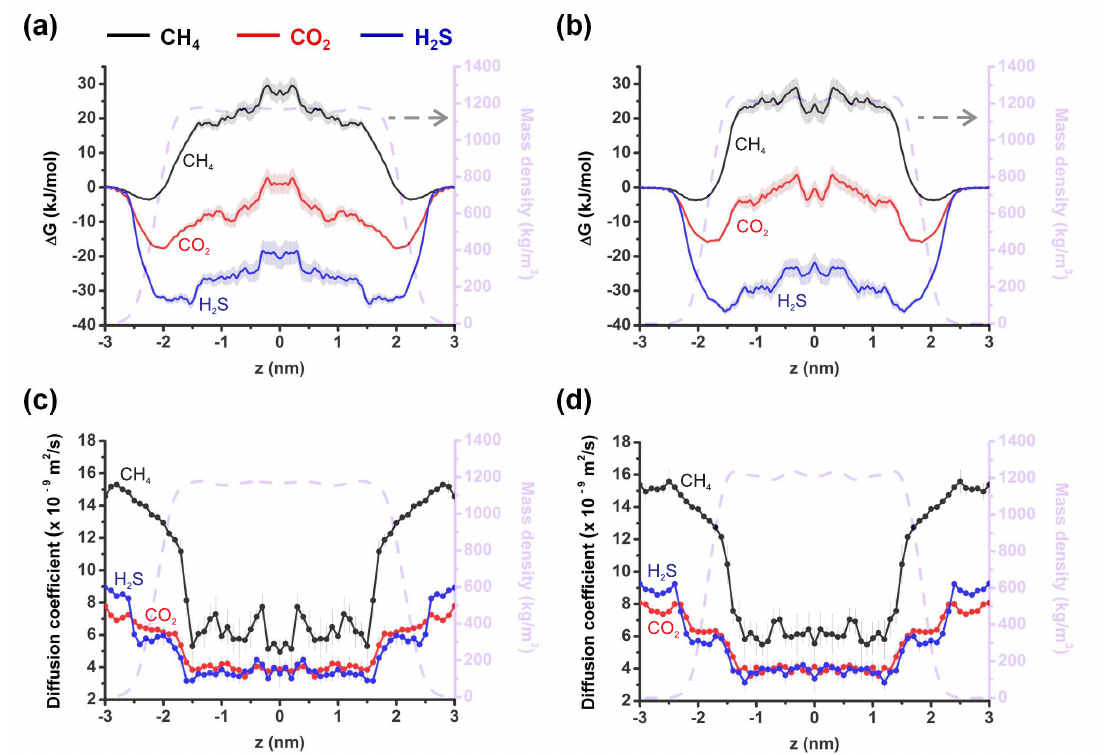
Figure 2. ( a , b ) Free energy profiles for the translocation of CH 4 (black curves), CO 2 (red curves) and H 2 S (blue curve) across choline-benzoate ( a ) and choline-lactate ( b ) systems. ( c , d ) Diffusion coefficient profiles of CH 4 (black curves), CO 2 (red curves) and H 2 S (blue curves) in choline-benzoate ( c ) and choline-lactate ( d ) samples. The dashed grey curves in all panels show the mass density of the corresponding systems. Errors associated with the US calculations are depicted in pale color which is obtained by means of bootstrapping method